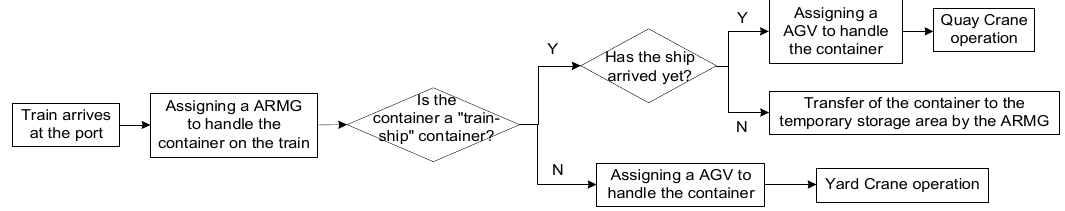
Figure 3. Sea–rail container handling operation process in mixed operation mode.